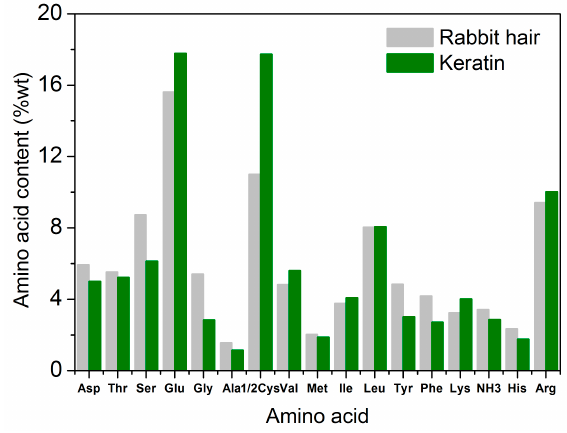
Figure 8. Amino acid content of rabbit hair and regenerated keratin by dissolving in DES at 120 °C.